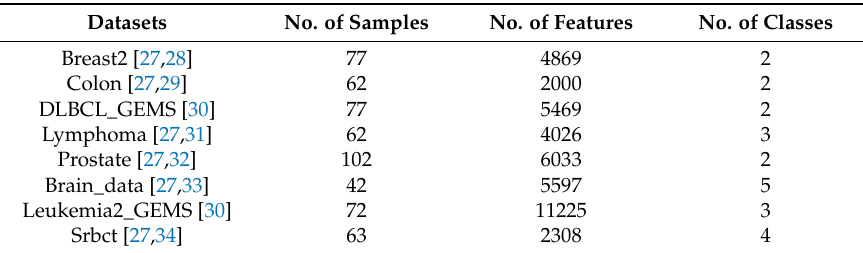
Table 1. Data description.